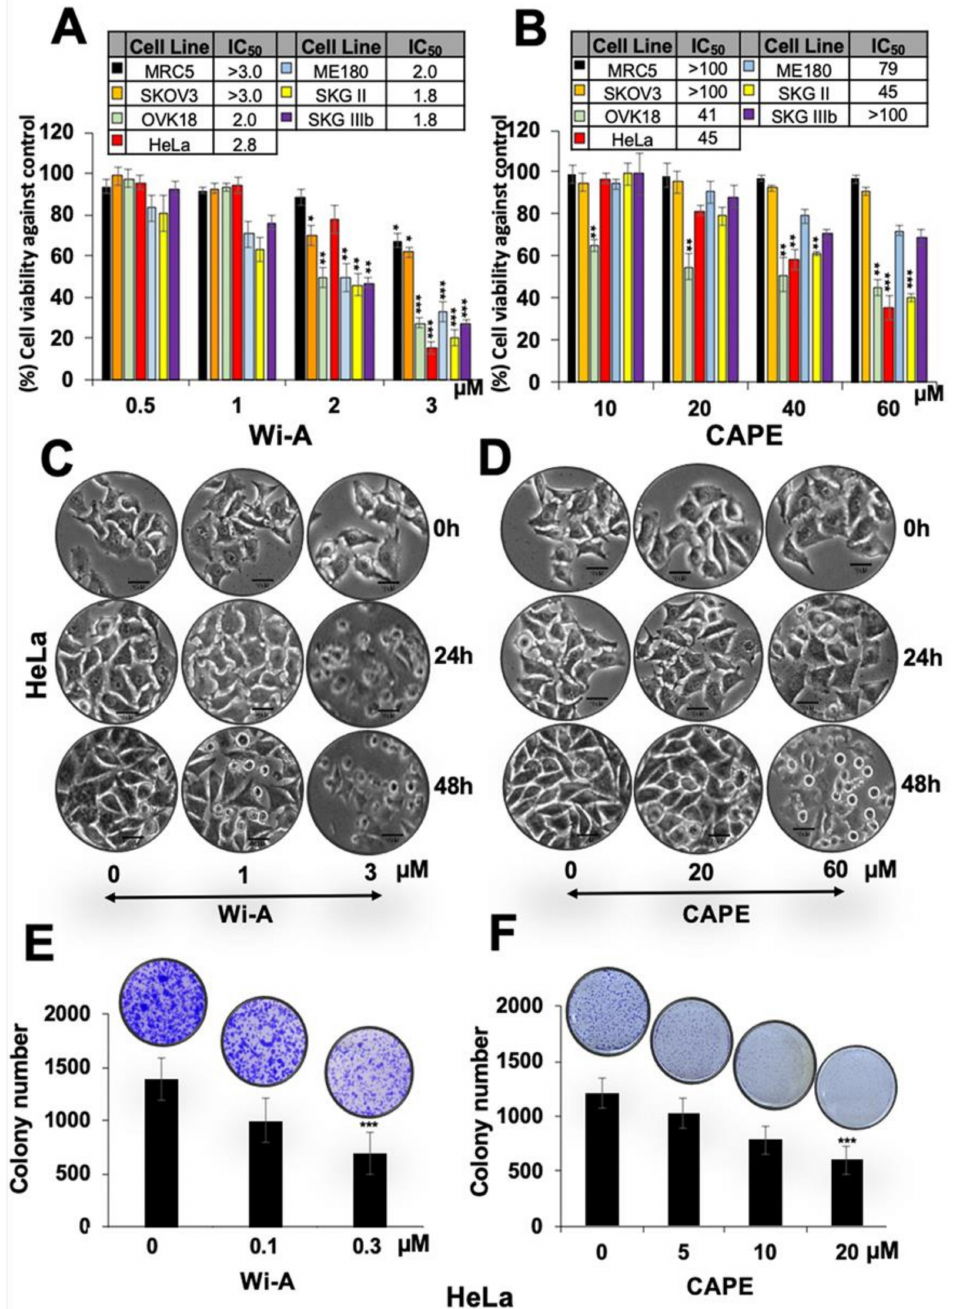
Figure 1. Dose dependent cytotoxicity of Withaferin A (Wi-A) and ca ff eic acid phenethyl ester (CAPE) to cervical and ovarian cancer cells. ( A , B ) 3-(4,5-dimethylthiazol-2-yl)-2,5-diphenyl tetrazolium bromide (MTT)-based cell viability assay showing cytotoxicity in various cell lines treated with Wi-A ( A ) or CAPE ( B ). IC 50 values for each of the cell types used are shown in Table inset in A and B. ( C , D ) Phase contrast images showing cell morphology at 24 h and 48 h treatment showing predominant growth arrest and apoptosis, respectively, when treated with Wi-A ( C ) or CAPE ( D ); Scale bar-10 µ M. ( E , F ) Long-term viability assay showing dose-dependent decrease in number of colonies (clonogenicity) for cells treated with either Wi-A ( E ) or CAPE ( F ). Data were normalized against the control and plotted as percent di ff erence. Each data set represents the mean ± SD for at least three independent biological replicates. Statistical significance was defined as p -values (*) where * < 0.05, ** < 0.01 and *** < 0.001 represent significant, very significant and highly significant,